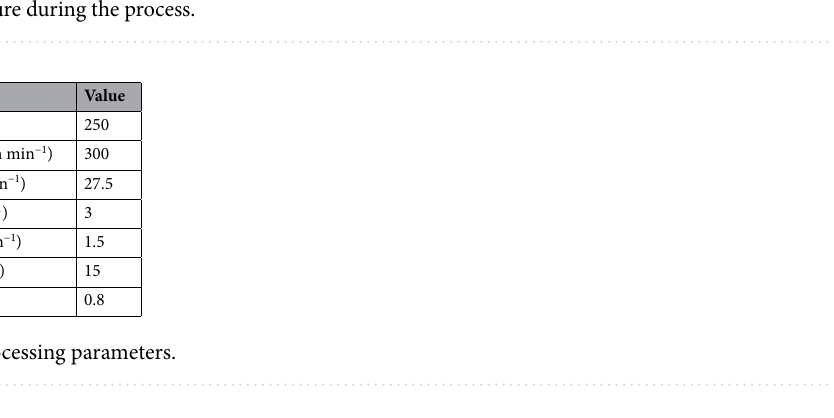
Figure 3. ( a ) Schematic of the multi-material structure (the thermocouple location: in the middle of the laser scanning/deposition path and 1 mm below the substrate surface). ( b ) Thermocouple and data logger used to measure temperature during the process.